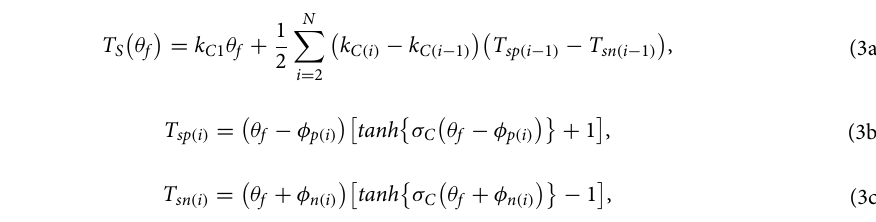
design concepts under various practical conditions. The mathematical model of nonlinear torque f n factor σ C of 1 × 10 3 is described as follows: